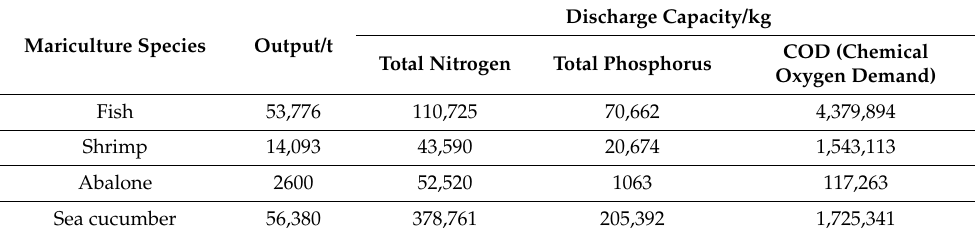
Table 1. Mariculture waste discharge of Liaoning province in